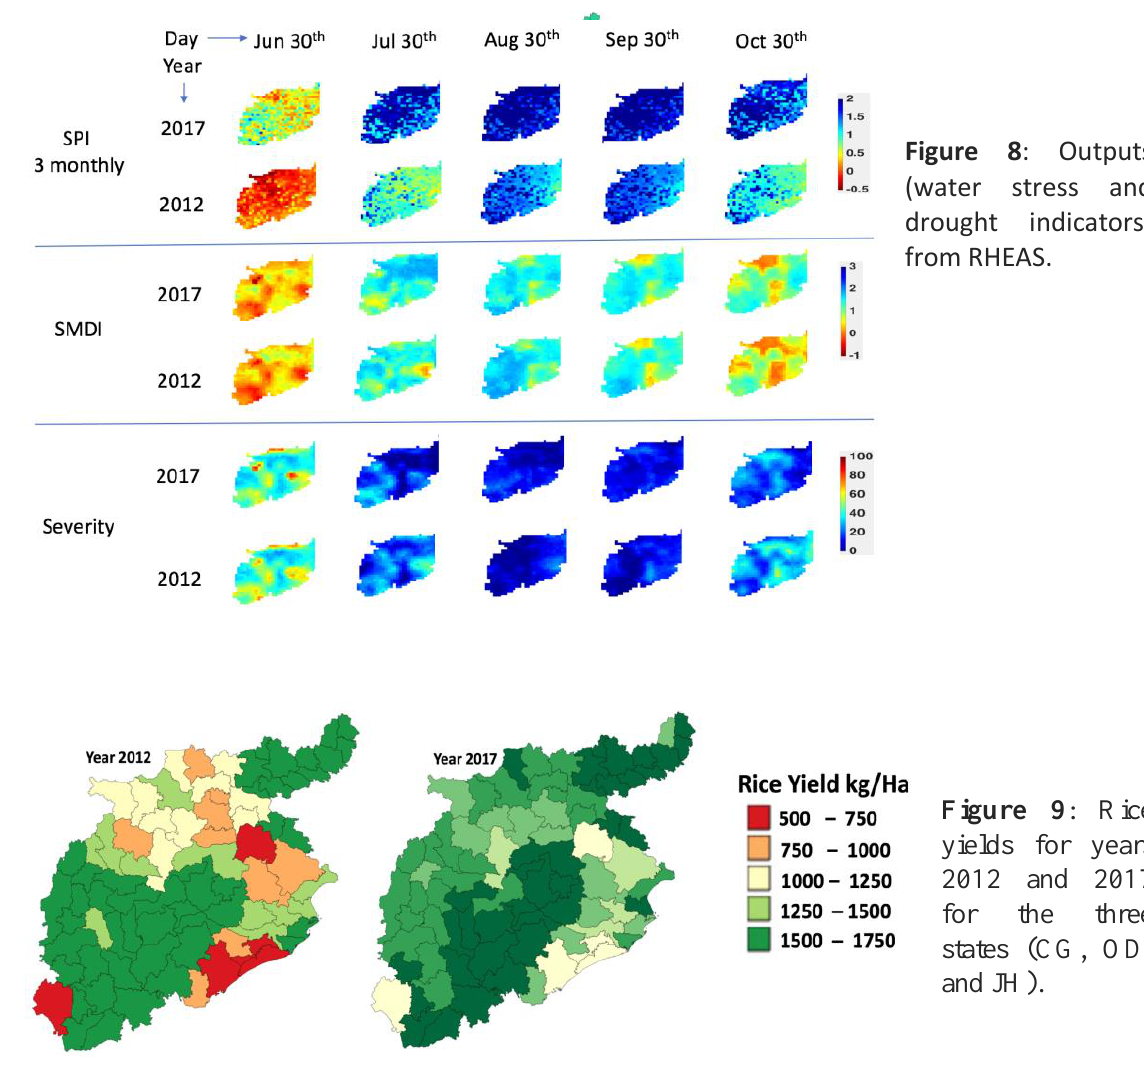
Figure 8 : Outputs (water stress and drought indicators) from RHEAS.